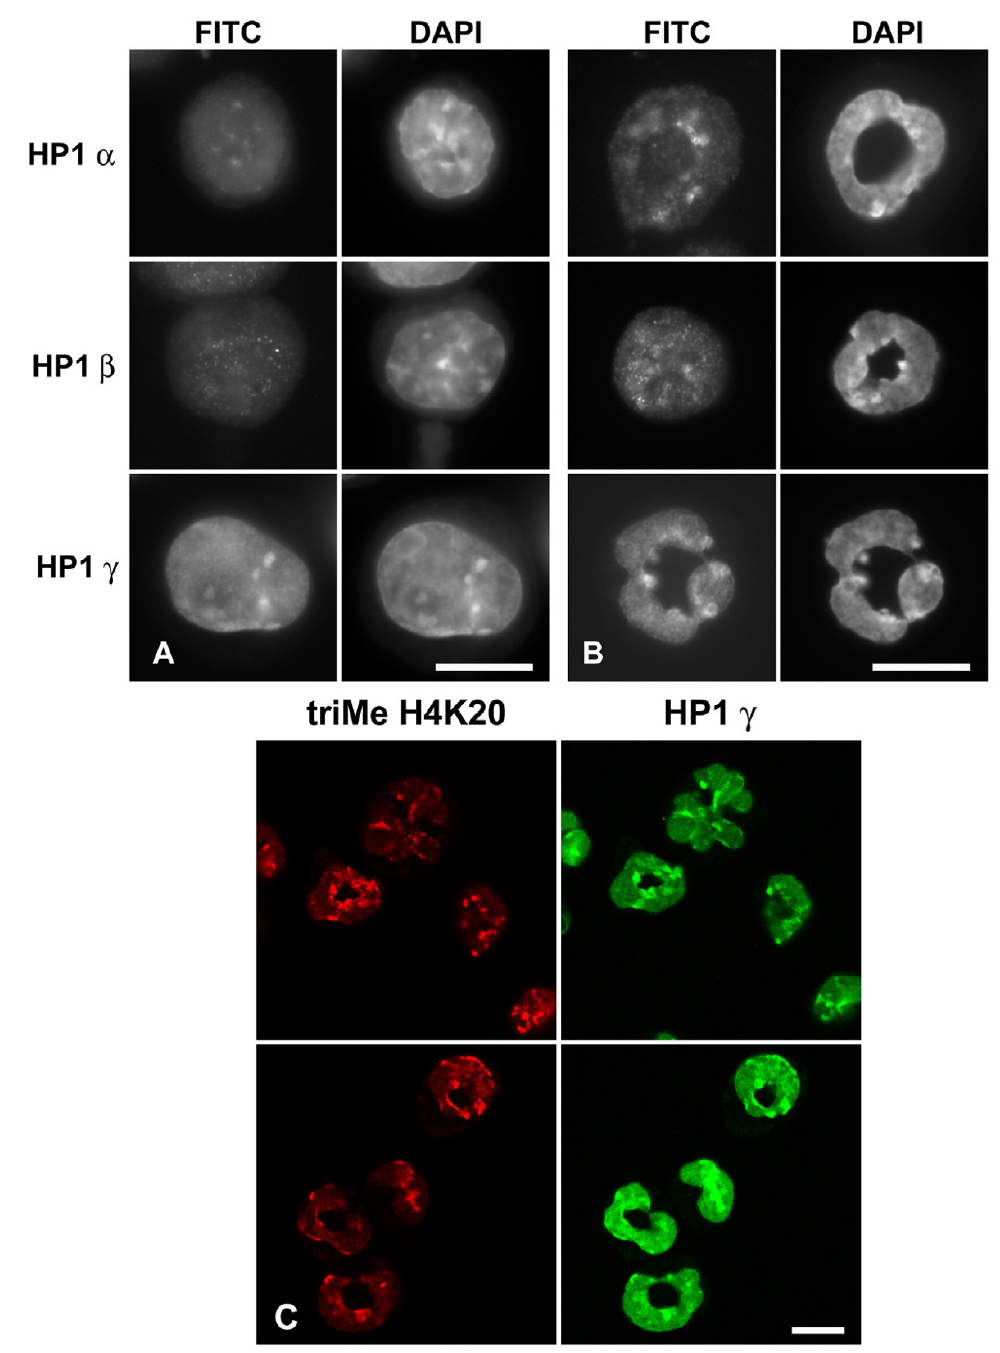
Figure 12 Immunostaining of MPRO cells with various HP1 antibodies . Panels: A, undifferentiated; B, granulocyte forms of MPRO. Columns: FITC, antibody staining viewed by conventional epifluorescent microscopy; DAPI (DNA staining). Cells were stained with anti-HP1 α , β and γ . Note the co-localization of anti-HP1 γ with DAPI-bright pericentric heterochromatin. Panel C: confocal images demonstrating co-localization of anti-trimethylated H4K20 with anti-HP1 γ stained granulocyte pericentric heterochromatin. Scale bars: 10 µ